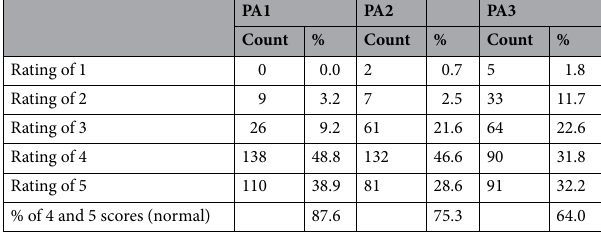
Table 2. The distribution of scores for each individual